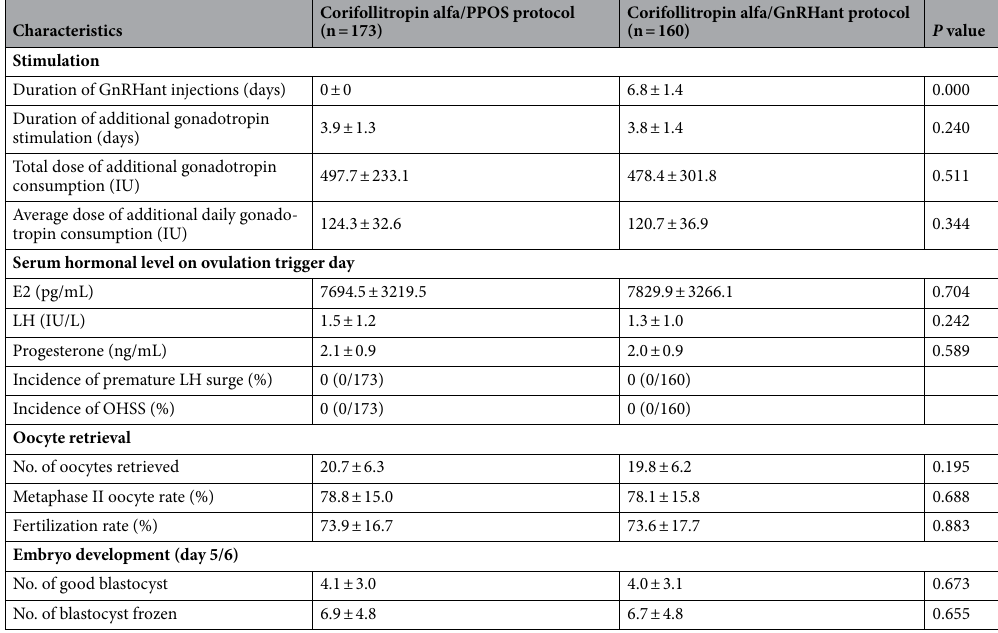
Table 2. Characteristics of ovarian stimulation, oocyte retrieval, fertilization, embryo development and embryo freezing. Values are expressed as either mean ± standard deviation or percentage. PPOS progestin primed ovarian stimulation, GnRHant GnRH antagonist, E2 estradiol, LH luteinizing hormone, OHSS ovarian hyperstimulation syndrome.